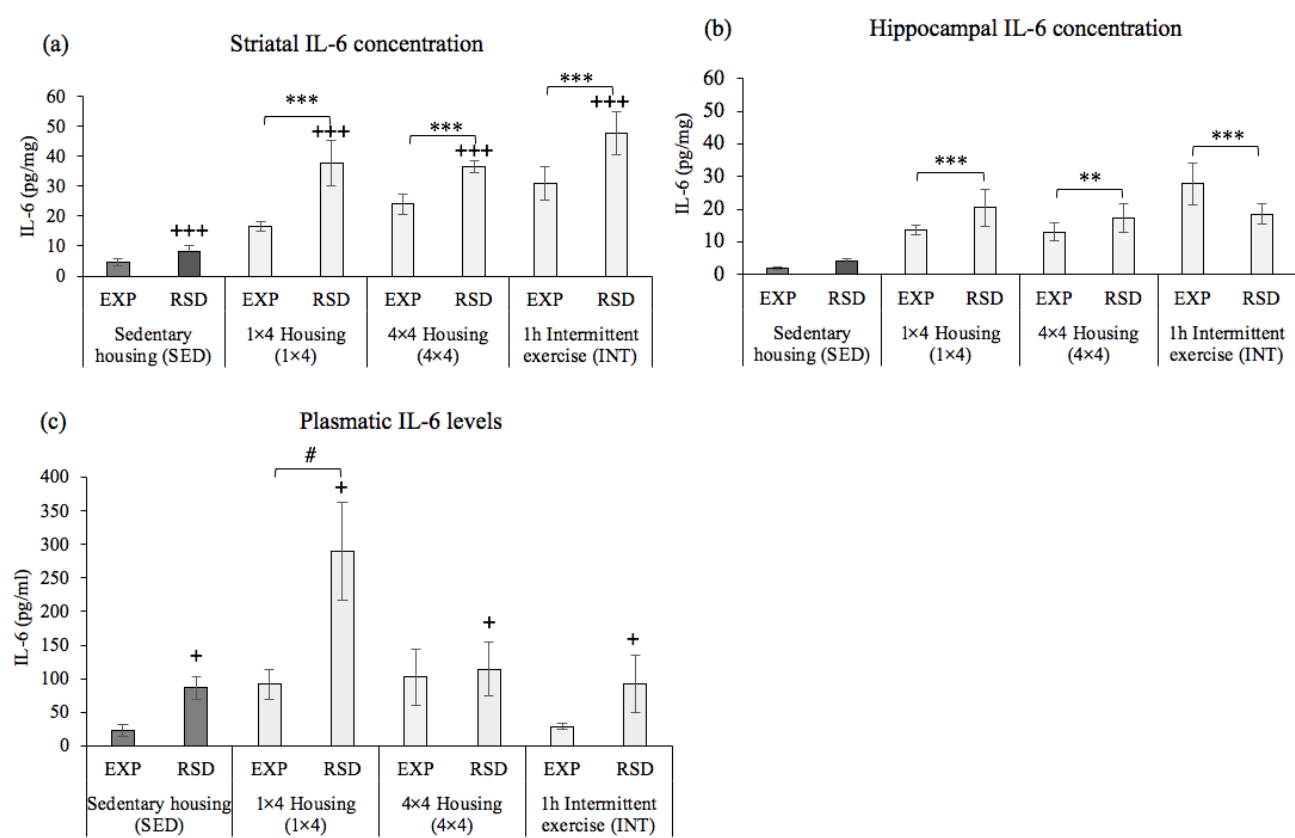
Figure 6. ( a ) Effects of voluntary wheel running on striatal levels of IL-6, ( b ) Effects of voluntary wheel running on hippocampal levels of IL-6, ( c ) Effects of voluntary wheel running on plasmatic levels of IL-6. Sedentary housing (SED – EXP n = 6; SED – RSD n = 6); one activity wheel per cage (1 × 4-EXP n = 8; 1 × 4-RSD n = 8); four activity wheels per cage (4 × 4-EXP n = 8; 4 × 4-RSD n = 7); regimen of intermittent exercise (INT – EXP n = 7; INT – RSD n = 7). Data are presented as mean values of IL-6 (pg/mg protein in brain tissue and pg/mL in plasma) ± SEM. Bonferroni’s test ** p < 0.01; *** p < 0.001 significant difference in IL-6 levels vs. sedentary housing (SED); + p < 0.05; +++ p < 0.001 significant difference in IL-6 levels between EXP vs. RSD; # p < 0.05 significant difference in IL-6 levels between 1 × 4 vs. SED and INT.